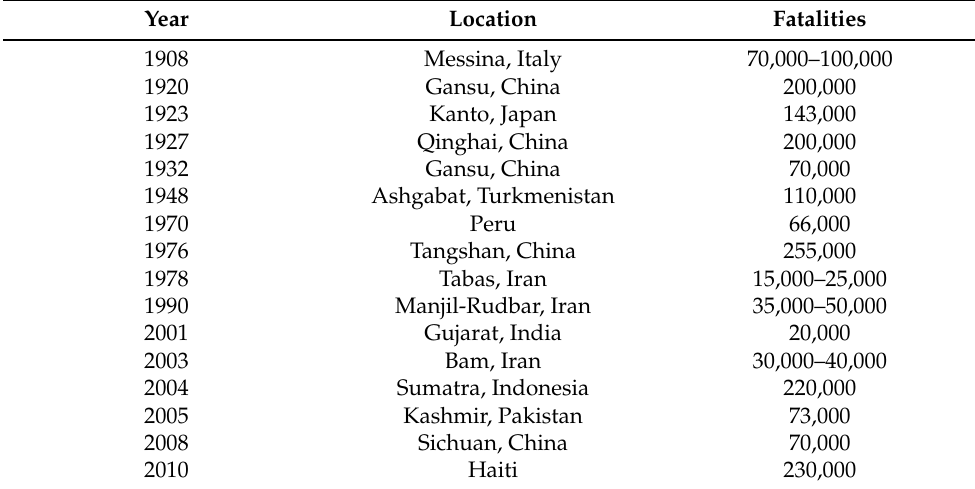
Table 1. Earthquakes with the highest number of casualties in the last century.